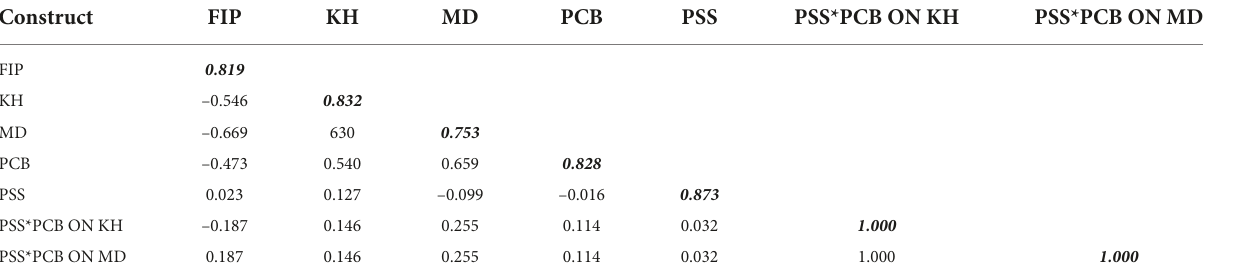
TABLE 7 Discriminant validity (Fornell-Larker-1981 criteria)